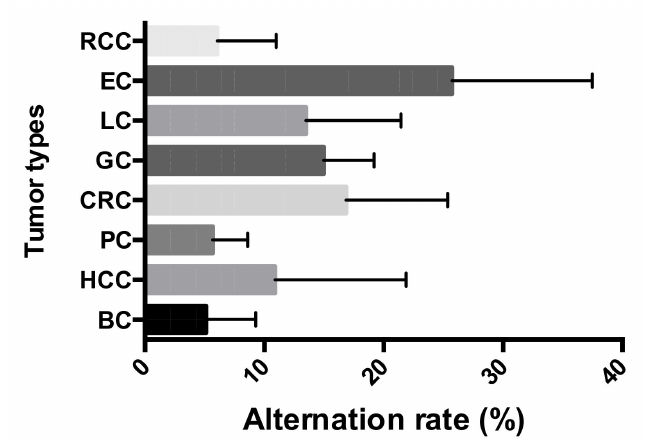
Figure 1. Short tandem repeat (STR) alteration frequencies across the eight tumor types: Breast cancer (BC), hepatocellular cancer (HCC), pancreatic cancer (PC), colorectal cancer (CRC), gastric cancer (GC), lung cancer (LC), esophageal cancer (EC), and renal cell cancer